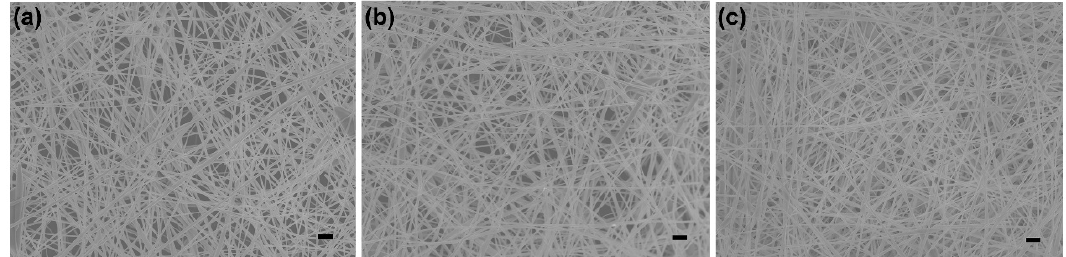
Figure 2. Optimization of the areal density of the silver NWs on a napkin. SEM images of the silver NWs on napkins with the density of 0.67 mg cm − 2 ( a ), 1 mg cm − 2 ( b ), and 1.33 mg cm − 2 ( c ), respectively. The scale bars are 1 µm.